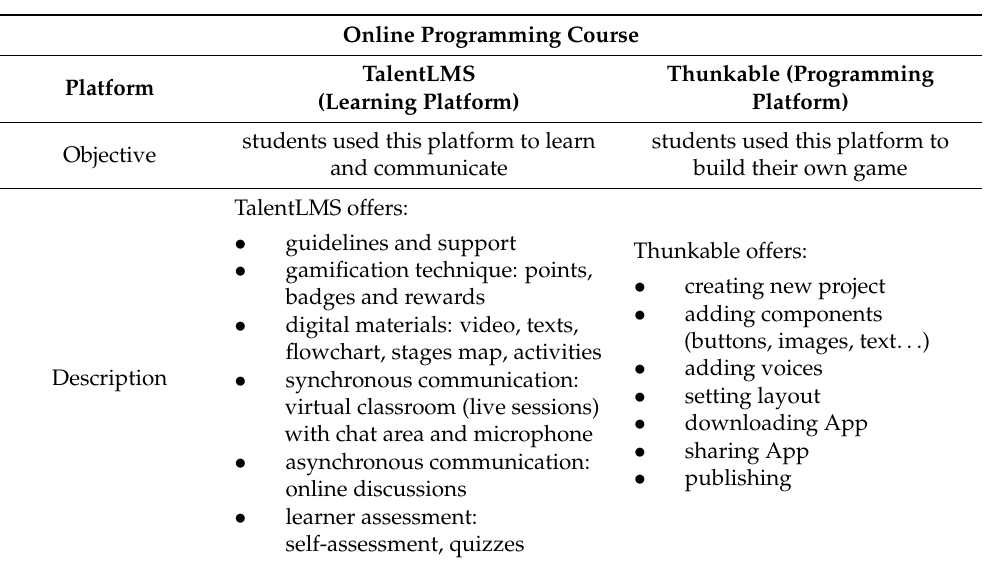
Table 1. The design of the online programming